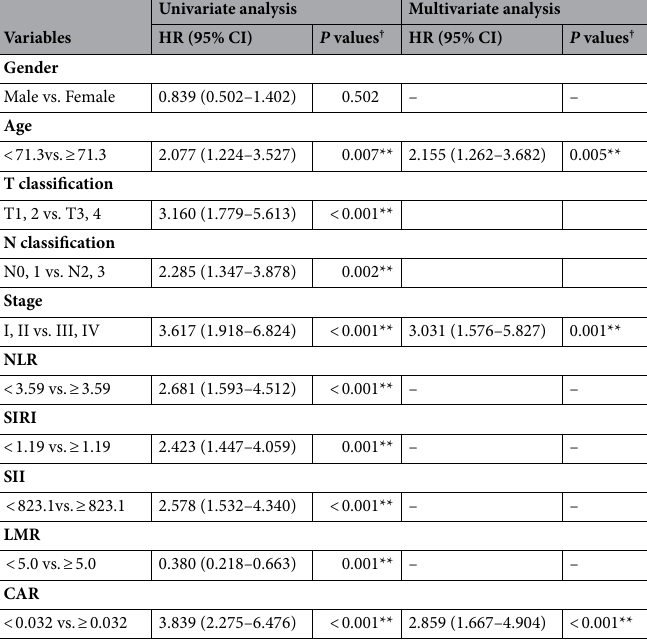
Table 4. Univariate and multivariate cox regression analyses for OS in the primary cohort. † By